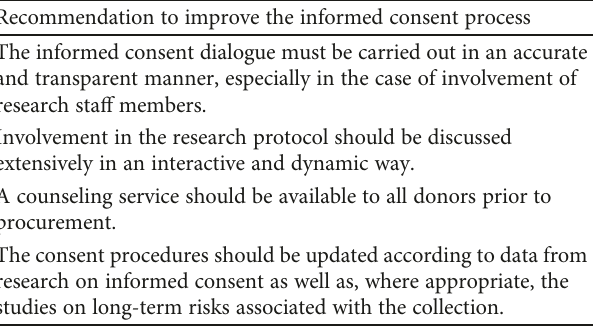
Table 4: Strategies to implement the informed consent process. Recommendation to improve the informed consent process The informed consent dialogue must be carried out in an accurate and transparent manner, especially in the case of involvement of research sta ff